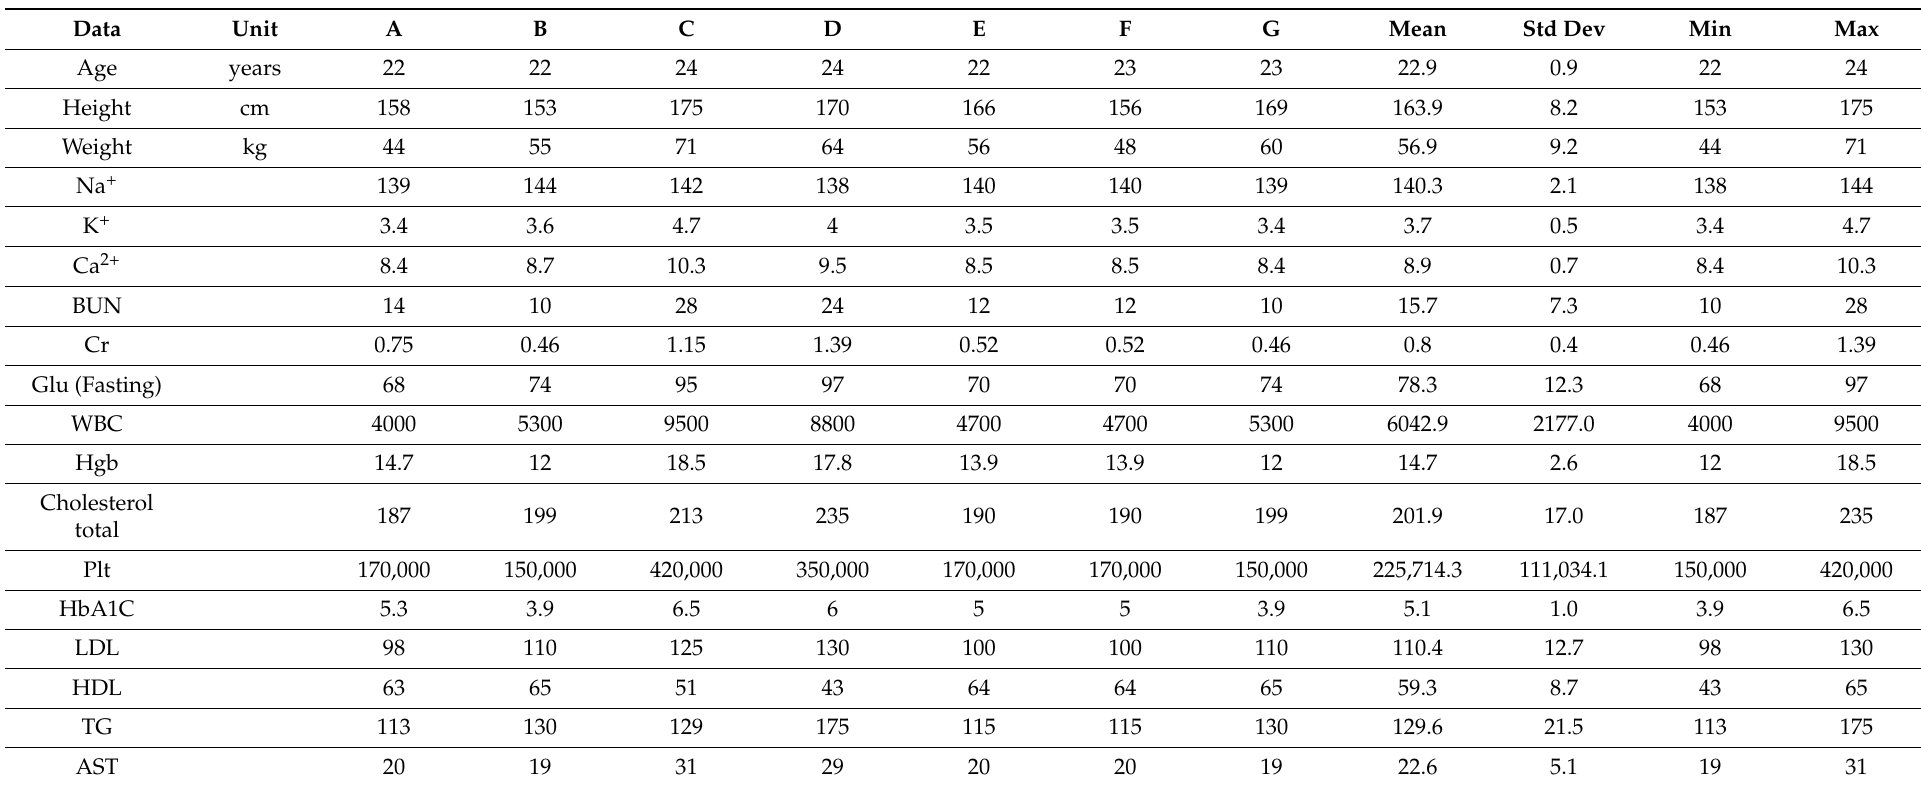
Table 1. Clinical examination (basic profile and blood